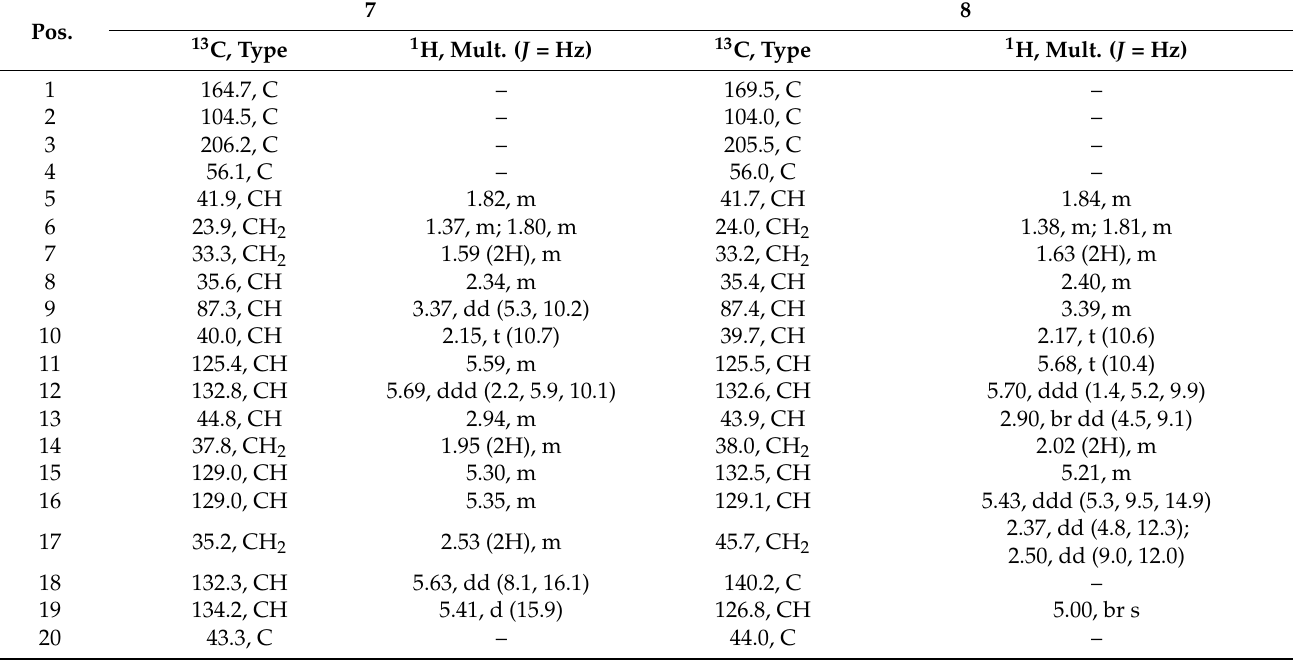
Table 1. 1 H (400 MHz) and 13 C (100 MHz) NMR data of decatromicins C ( 7 ) and D ( 8 ) in MeOH- d 4